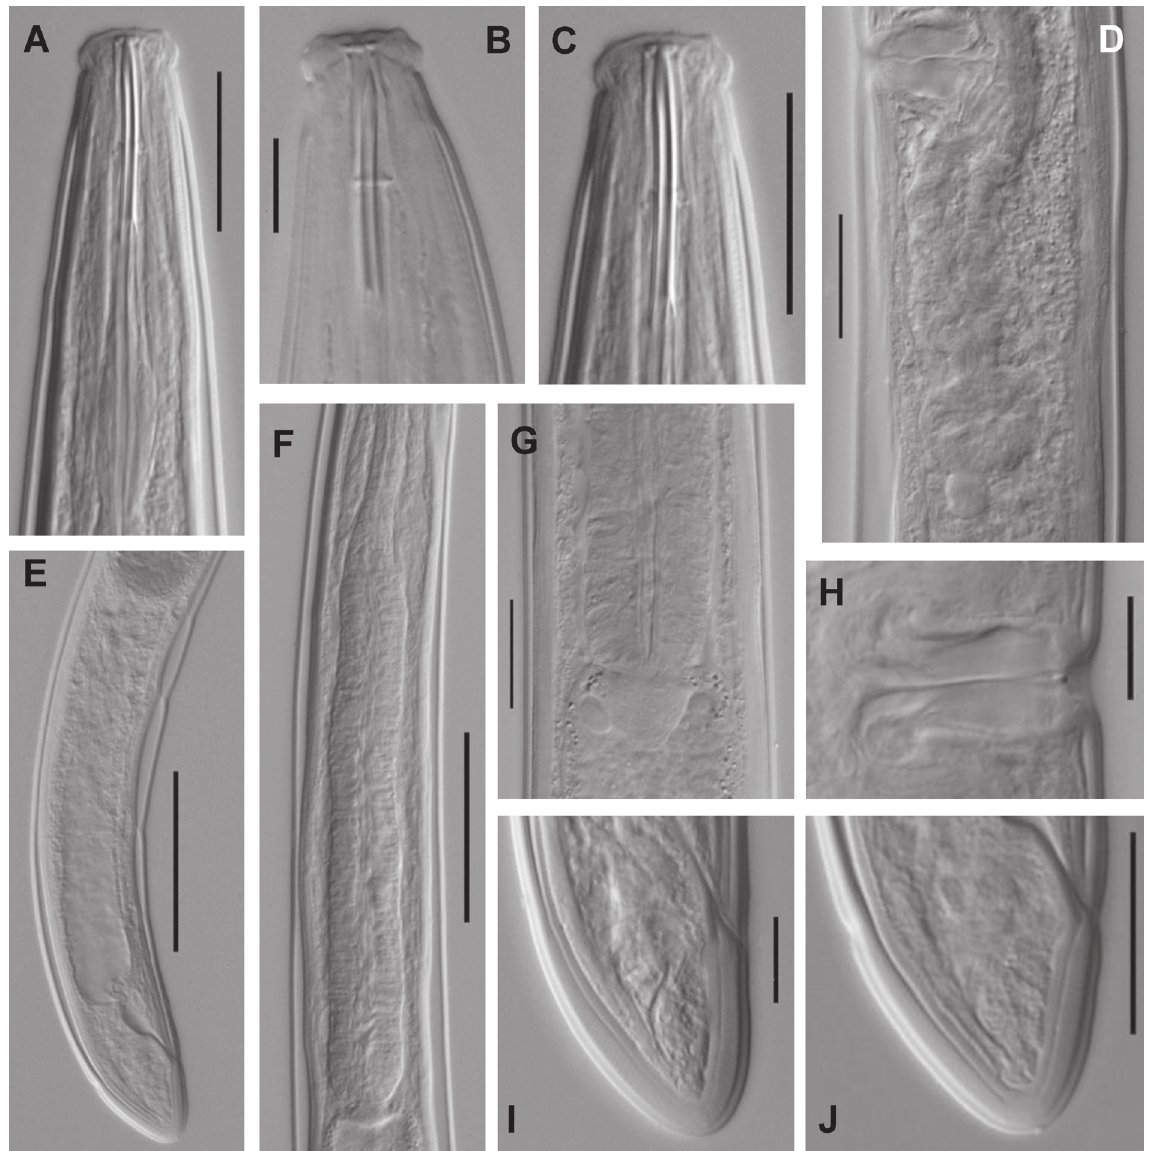
Fig. 5. Pungentus marietani Altherr, 1950 (♀, LM). A-C . Anterior region in median view. D . Posterior genital branch. E . Posterior body region. F . Phayngeal expansion. G . Phayngo-intestinal junction. H . Vagina. I-J . Caudal region. (Scale bars: A, C, D, G, J = 20 µm; B, H, I = 10 µm; E, F = 50